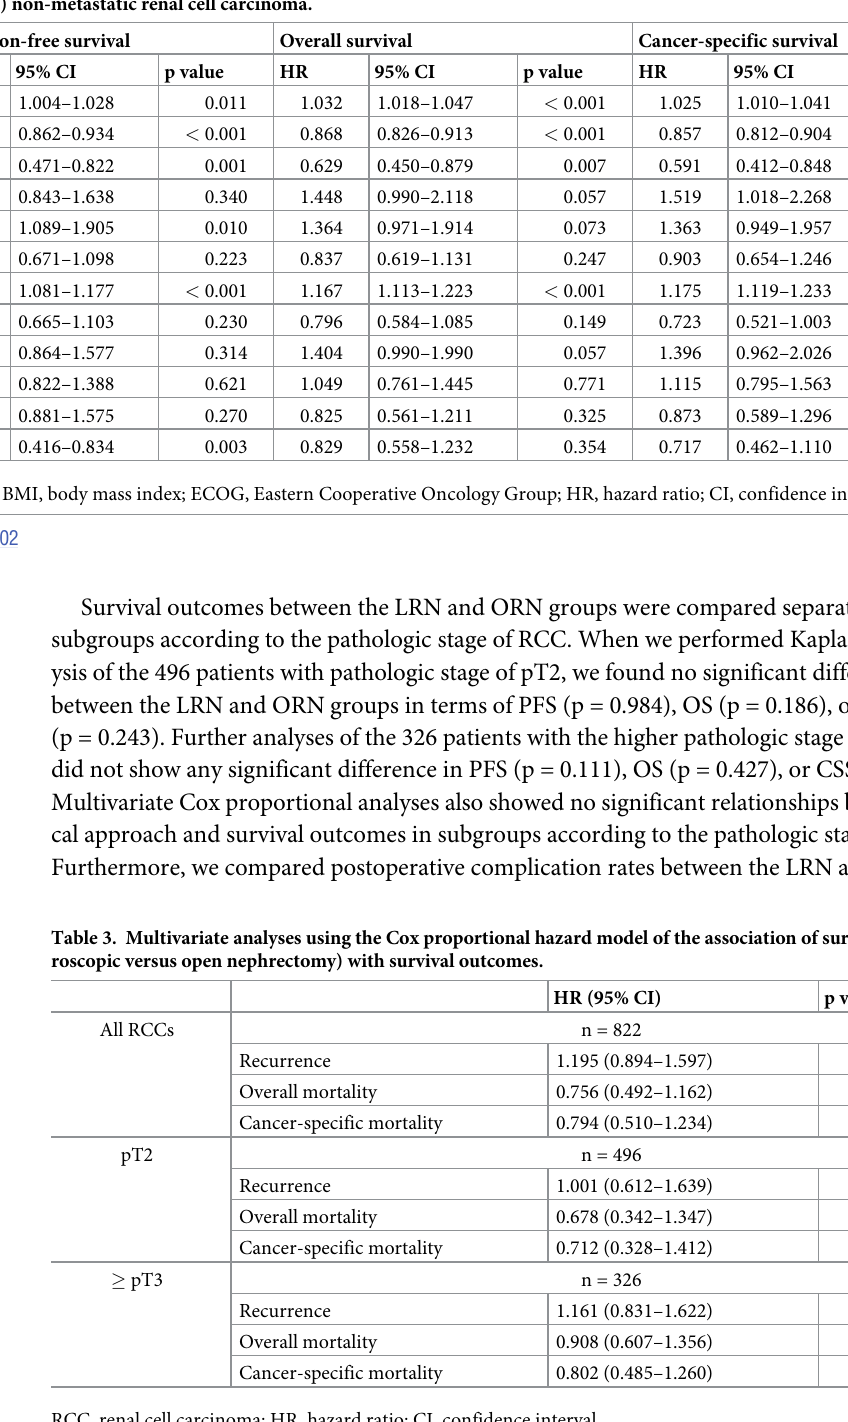
All multivariate analyses were adjusted for the following variables: age, sex, body mass index, American Society of Anesthesiologists score, T stage (not included in the subgroup analyses), tumor size, Fuhrman grade, and cellular